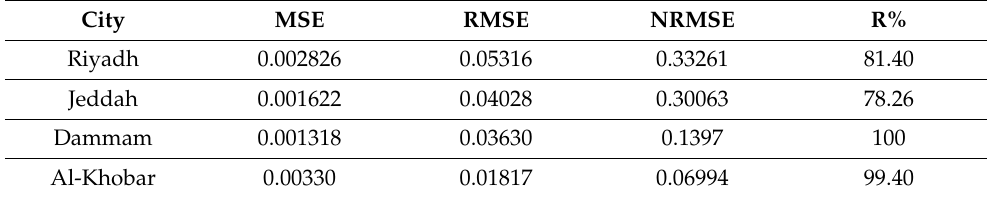
Table 3. ANN model results in the training